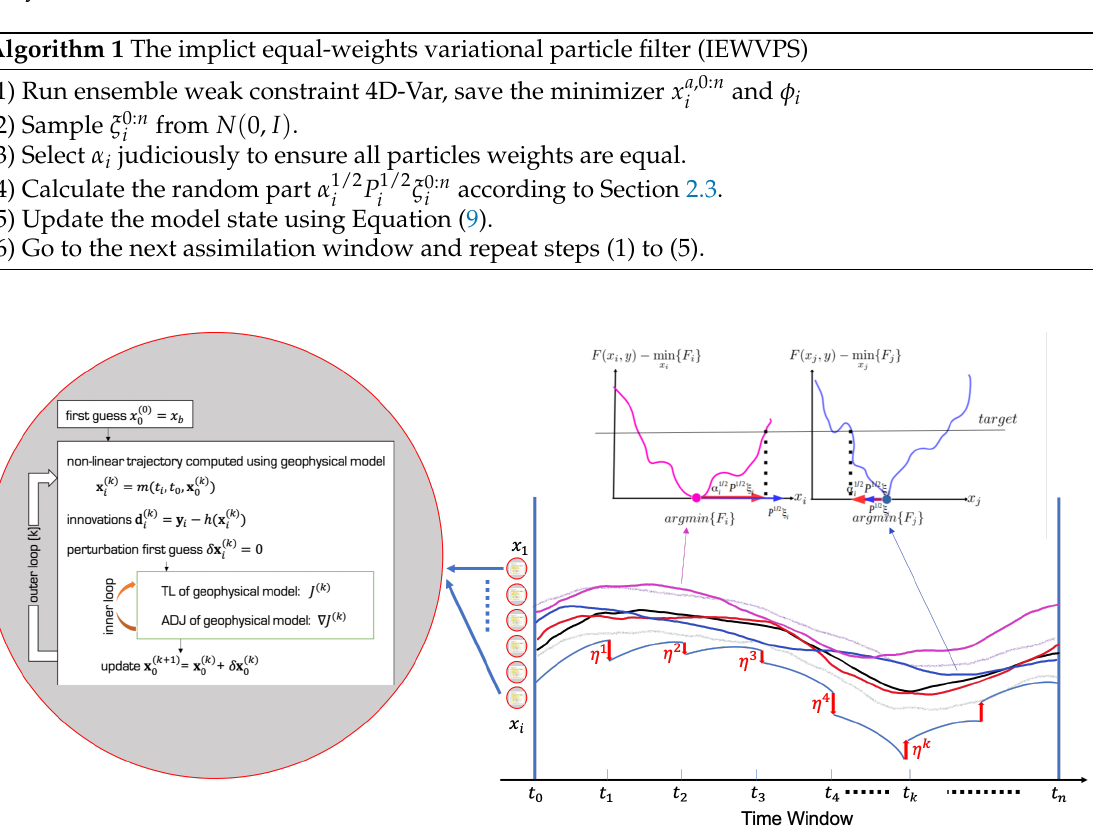
Figure 1. Schematic diagram of the implicit equal-weights variational particle smoother